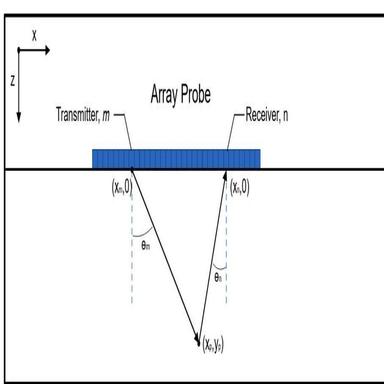
Geometrical representation of the time of flight calculation for a phase array probe for an emitting element m, receiving element n, for a reflector p in an x,z orthogonnal axis system. Incident and scattered angles are defined as ɵm and ɵn.